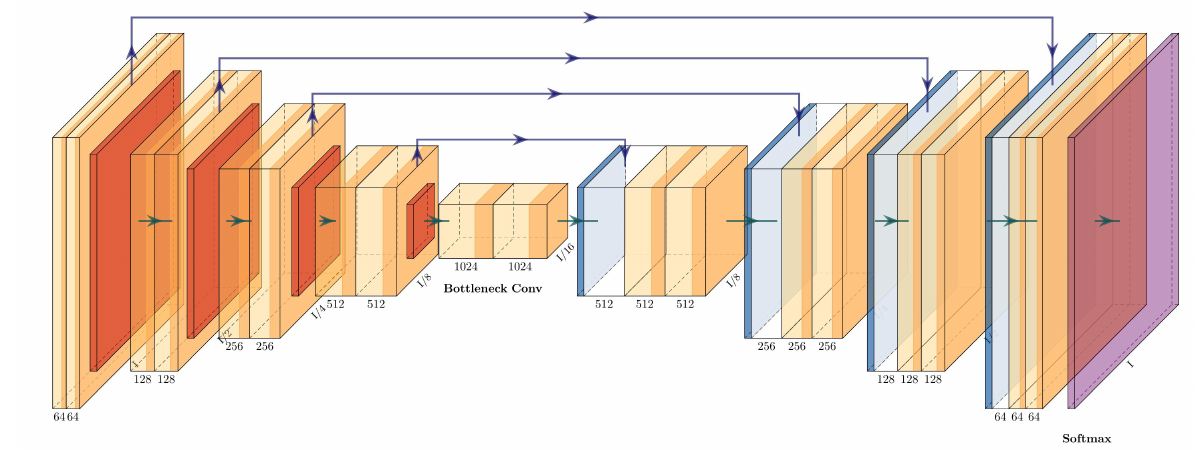
Figure 7. Architecture of the